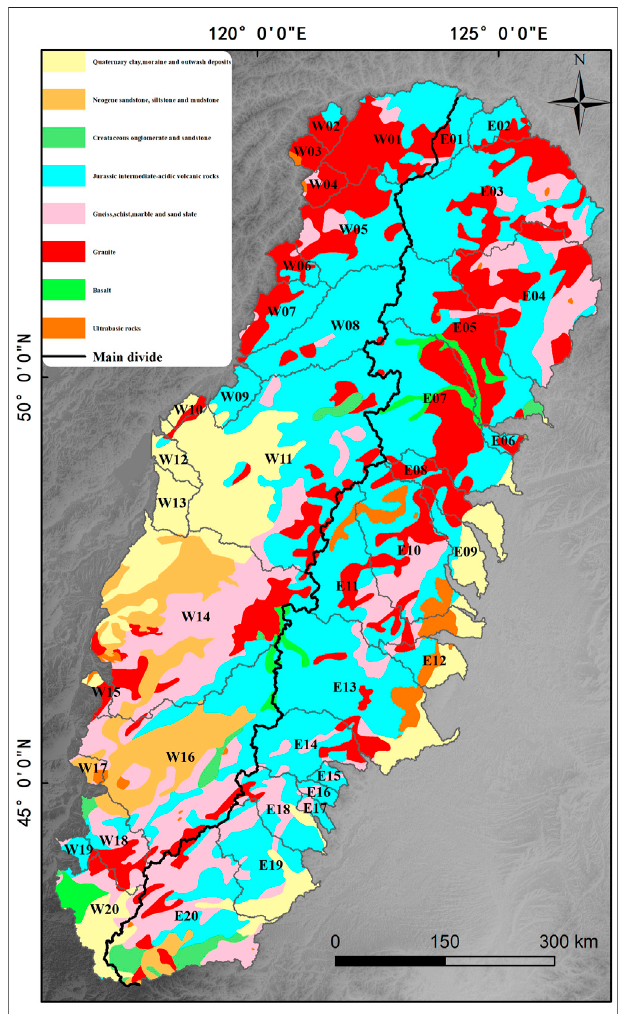
FIGURE 12 | Geological map of the Greater Khingan